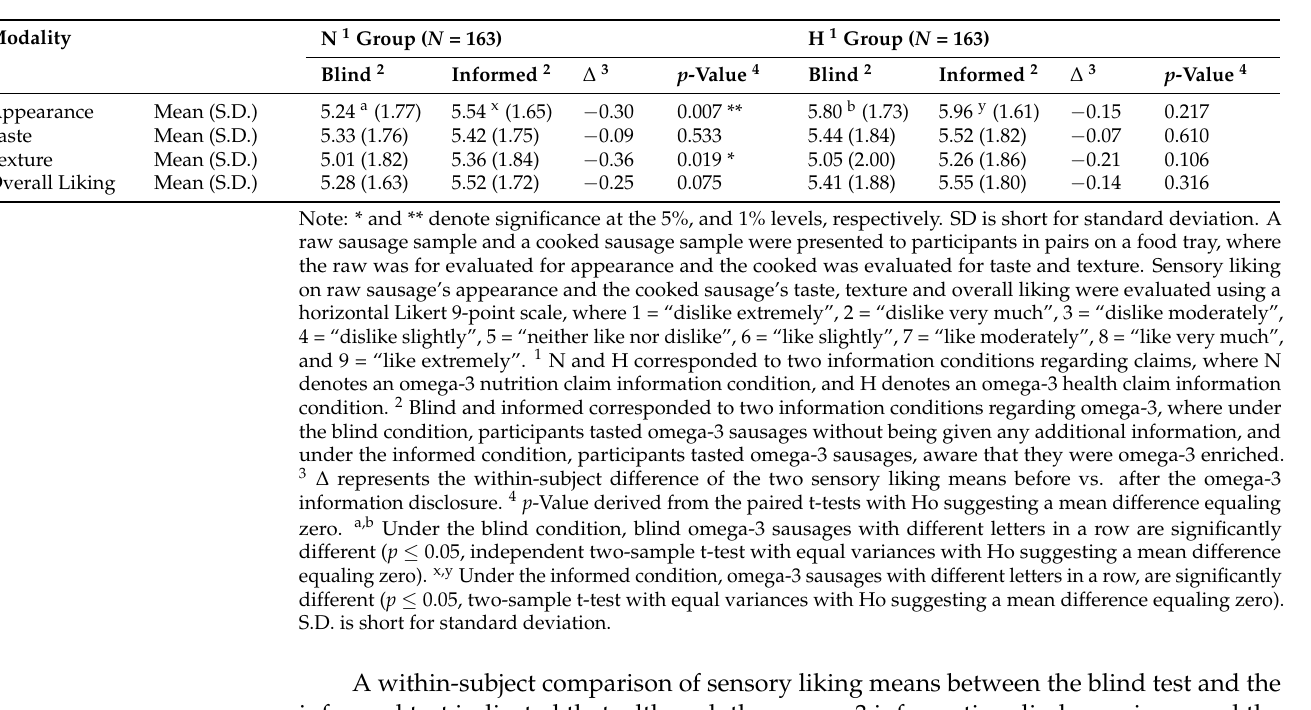
Table 3. Sensory liking means for omega-3-enriched